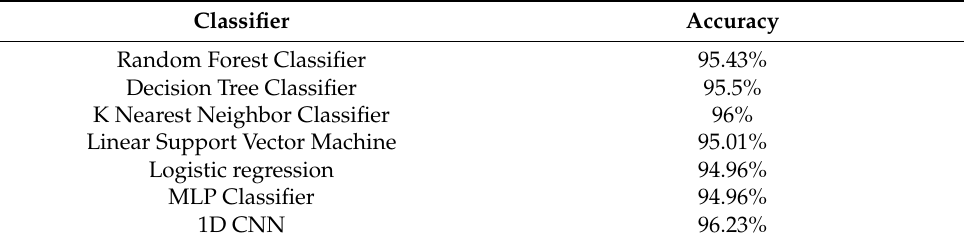
Table 4. Performance of the multiclass classification of the data by various ML models.